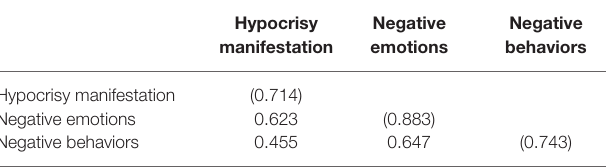
TABLE 4 | Square root of the AVE and correlation coefficient